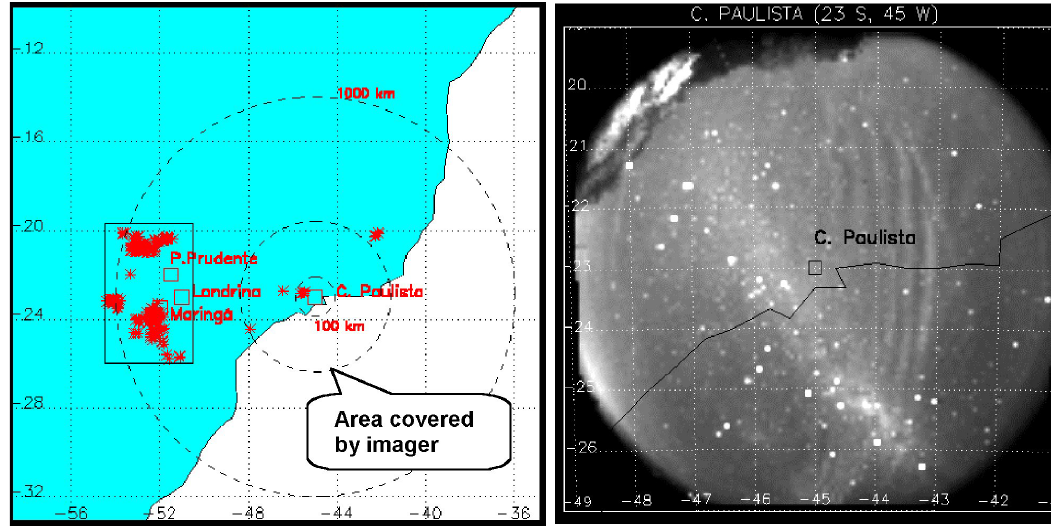
Fig. 11. The left-hand panel shows the location of the airglow imager and tropical storms (detected via lightning strikes), and the right-hand panel shows the GW-modulated airglow emission (Medeiros, personal communication).